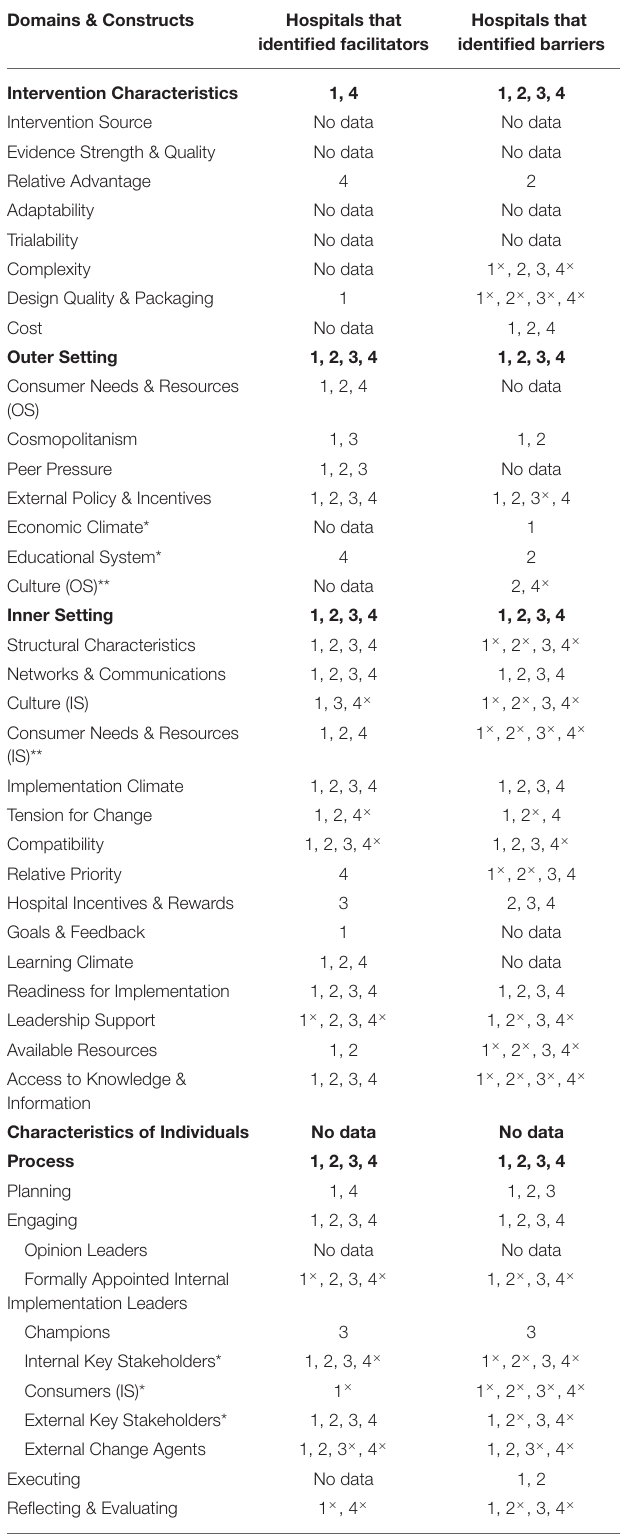
TABLE 2 | Summary of perceived barriers and facilitators to implementation of calorie posting policy. Domains &